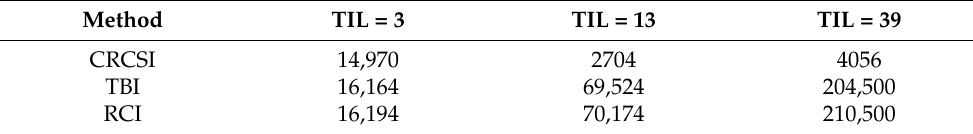
Table 4. Multiplicity D tot for different depths in mobile